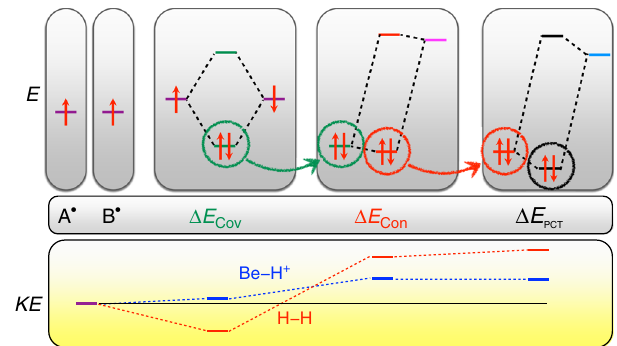
Fig. 4 Interpretation of the chemical bond. After orbital preparation, strong interaction between radicals that have degenerate (or close) energy levels gives rise to electron pairing with frozen orbitals ( Δ E Cov , in green). This may or may not be accompanied by KE lowering as discussed in the text. Next, further energy lowering occurs by orbital mixing of the initial covalent state (green) with much higher states (pink). Such mixing has the effect of lowering the total energy ( Δ E Con , red) and contracting the electron density towards the atomic centers, as shown above the mixing diagrams (exaggerated for visual effect). This effect is signi fi cant for H – H and A – H bonds, but much less so for A – B bonds. Mixing with other unoccupied states (light blue) further lowers the energy via polarization and charge transfer ( Δ E PCT , black), which is signi fi cant for many A – B bonds 19 . While all of these terms are stabilizing in total energy, they may either increase or decrease the KE depending on the system (bottom